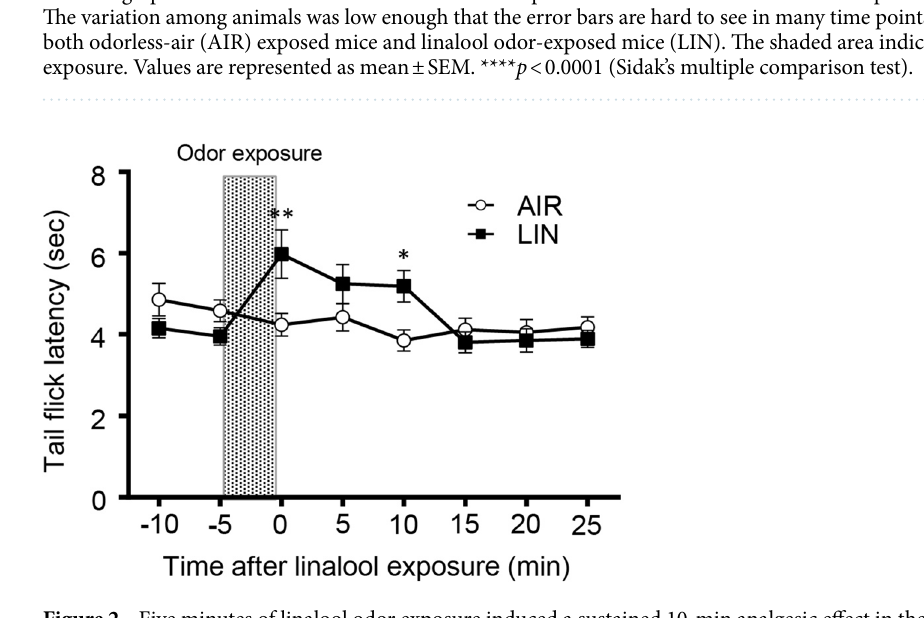
Figure 2. Five minutes of linalool odor exposure induced a sustained 10-min analgesic effect in the tail immersion test. The graph indicates the alteration of tail flick latency for thermal nociceptive stimulation. n = 10 for both odorless-air exposed mice (AIR) and linalool odor-exposed mice (LIN). The shaded area indicates odor exposure. Values are represented as mean ± SEM. ** p < 0.005; * p < 0.05 (Sidak’s multiple comparison